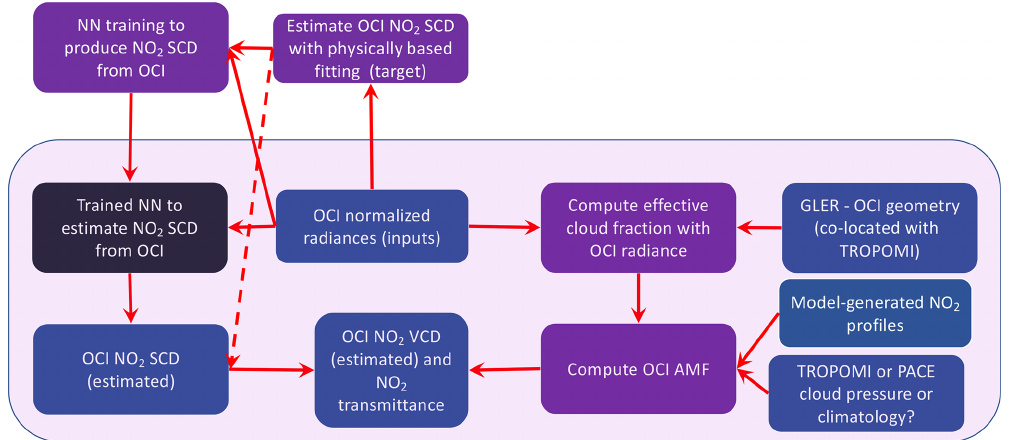
Figure 8. Similar to Fig. 7 but showing processes to estimate NO 2 VCD using only OCI data. The dashed line shows an alternative flow that does not require training a